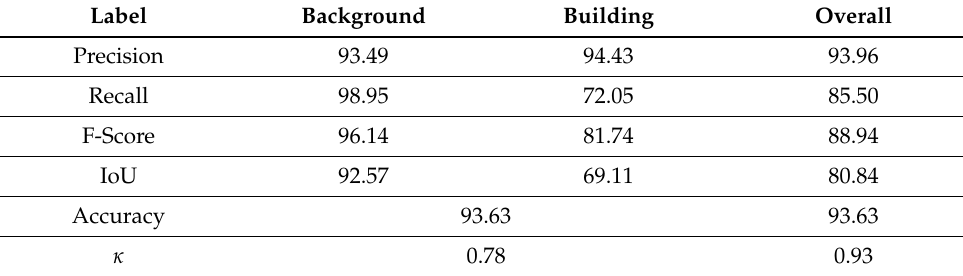
Figure 6. Visual results of our Bayesian U-Net on the INRIA dataset. Table 2. Accuracy metrics of our Bayesian U-Net on the INRIA